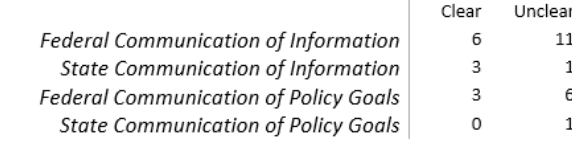
Table 5: Local government perception of the clarity of information and messages sent by federal and state government